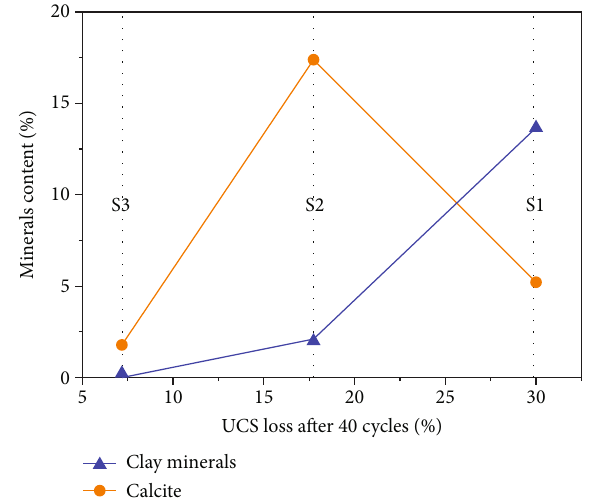
Figure 8: Relationship between UCS loss percentage and mineral